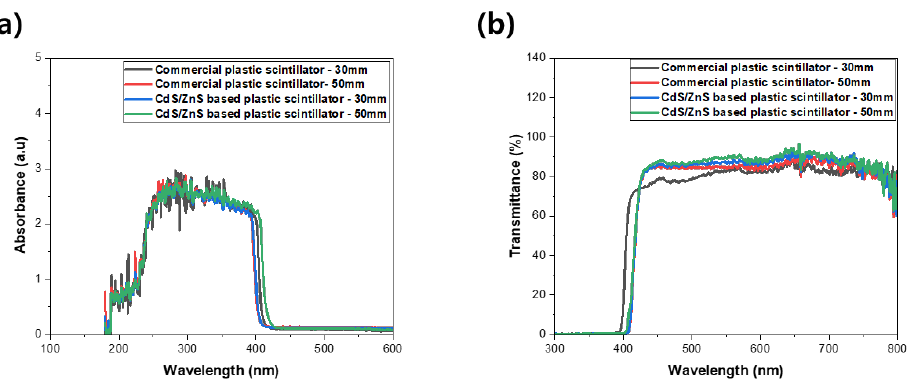
Figure 3. Absorption and transmittance measurement results of commercial plastics and CdS/ZnS- loaded plastic scintillators: ( a ) absorbance; ( b ) transmittance.